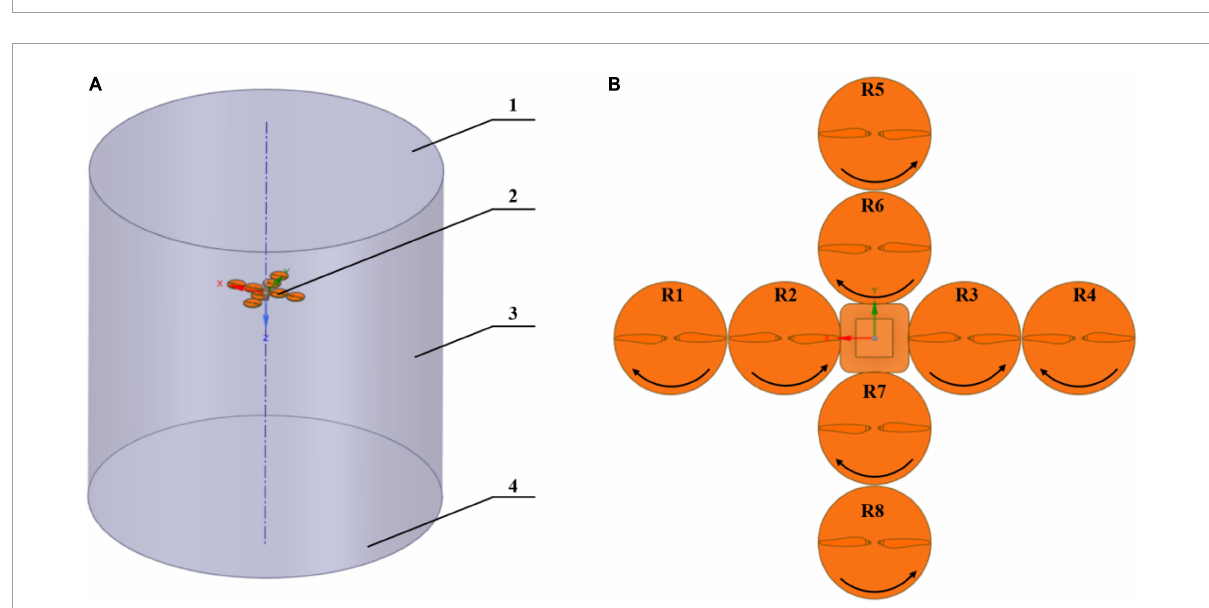
FIGURE4 Computational domain settings in numerical simulation. (A) Stands for the name of the boundary condition, where 1 represents the top surface of the computational domain, 2 represents the location of the mUAV, 3 represents the space wall, and 4 represents the ground. (B) Stands the top view of the rotor in the computational domain, where R1–R8 represents each rotor, respectively, and the corresponding black portion of arrows represent the direction of rotation of that rotor in the computational